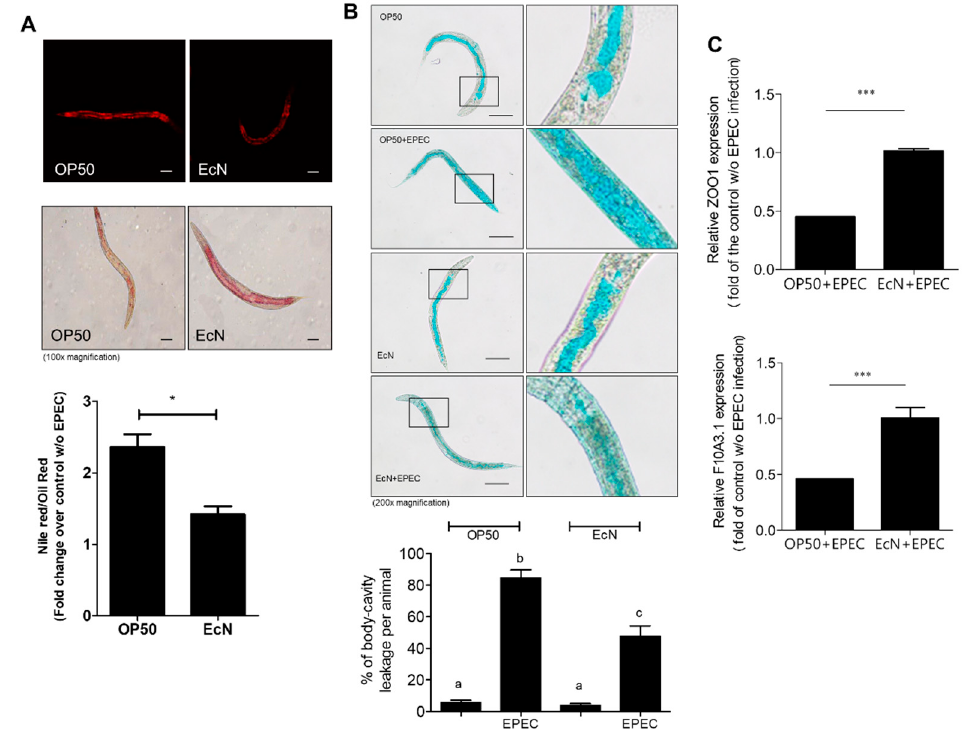
Figure 2. Effect of EcN on gut barrier in worms. ( A ) Wild-type (N2) worms were exposed to EPEC (without tryptophan) for 24 h after being fed E. coli OP50 and EcN for 24 h. The collected worms of each group were stained with Nile Red (the upper panels) or Oil Red O (the middle panels). The ratios of Nile Red to Oil Red O were calculated to determine the permeability of the gut barrier of Caenorhabditis elegans (×100; scale bar(s), 100 μ m) (the lower graph). Data represent mean ± SD (standard deviation) ( n = 10; * p < 0.05 compared with the vehicle control group). ( B ) The gut permeability was further verified using the Smurf assay. Presynchronized wild-type L4 worms were exposed to EPEC (without tryptophan) for 24 h after being fed E. coli OP50 and EcN for 24 h. The control groups (OP50 and EcN) were exposed to E. coli OP50 for 24 h instead of EPEC treatment (original magnification ×200). The lower graph shows % of body-cavity leakage per animal. Different letters over each bar represent significant differences between groups ( p < 0.05). ( C ) Quantification of ZOO-1 (human ZO-1 homologue) and F10A3.1 (human Claudin homologue) mRNA was performed to confirm the barrier function using real-time qPCR. After C. elegans were fed different types of E. coli strain, such as OP50 and EcN bacteria for 24 h, they were exposed to EPEC (without tryptophan) for 3 h. Asterisk represents significant differences between the groups (*** p < 0.001). Each result is representative of three independent experiments.